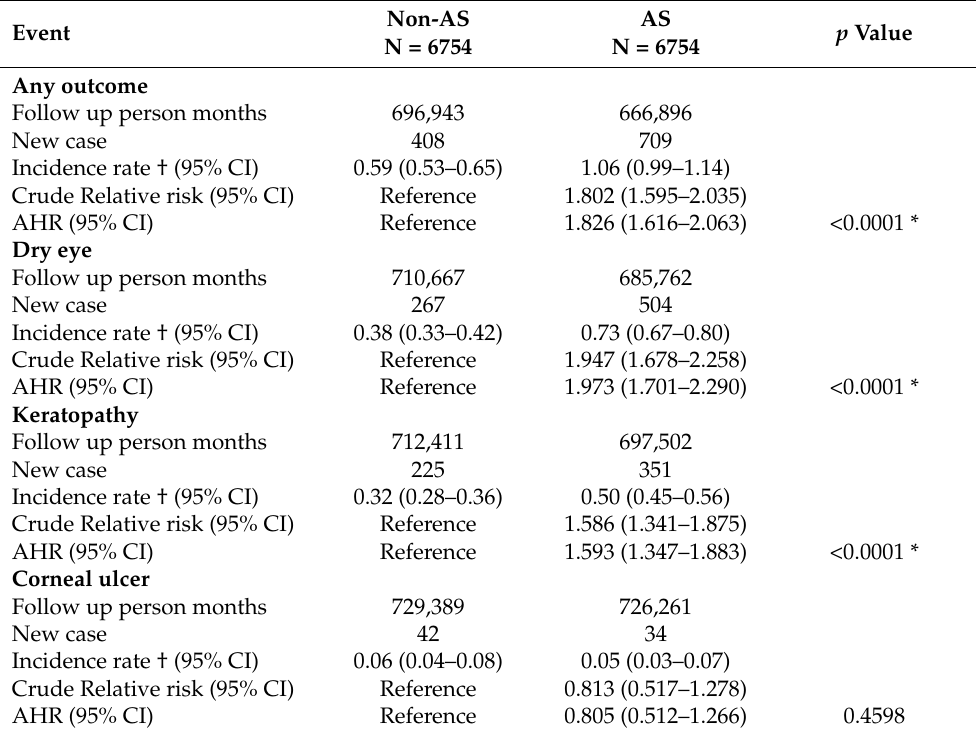
Table 2. Incidence risk of main outcome between propensity score matched ankylosing spondylitis and non-ankylosing spondylitis